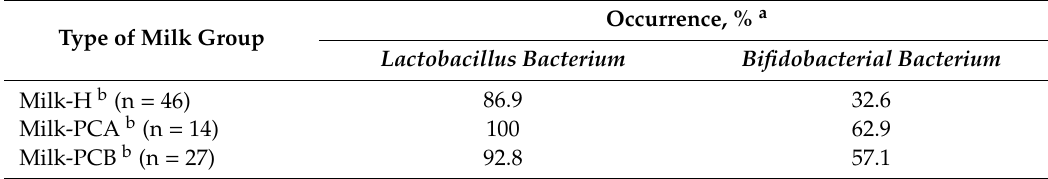
Table 2. The prevalence of Lactobacillus or Bifidobacterial bacteria in the three milk groups. Type of Milk Group